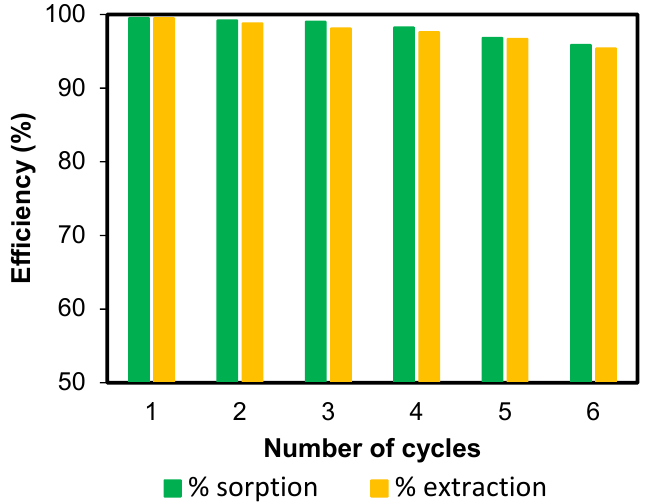
Figure 15. Reusability study of poly(hydroxamic acid) ligand in 6 cycles of adsorption-desorption of cobalt ions.